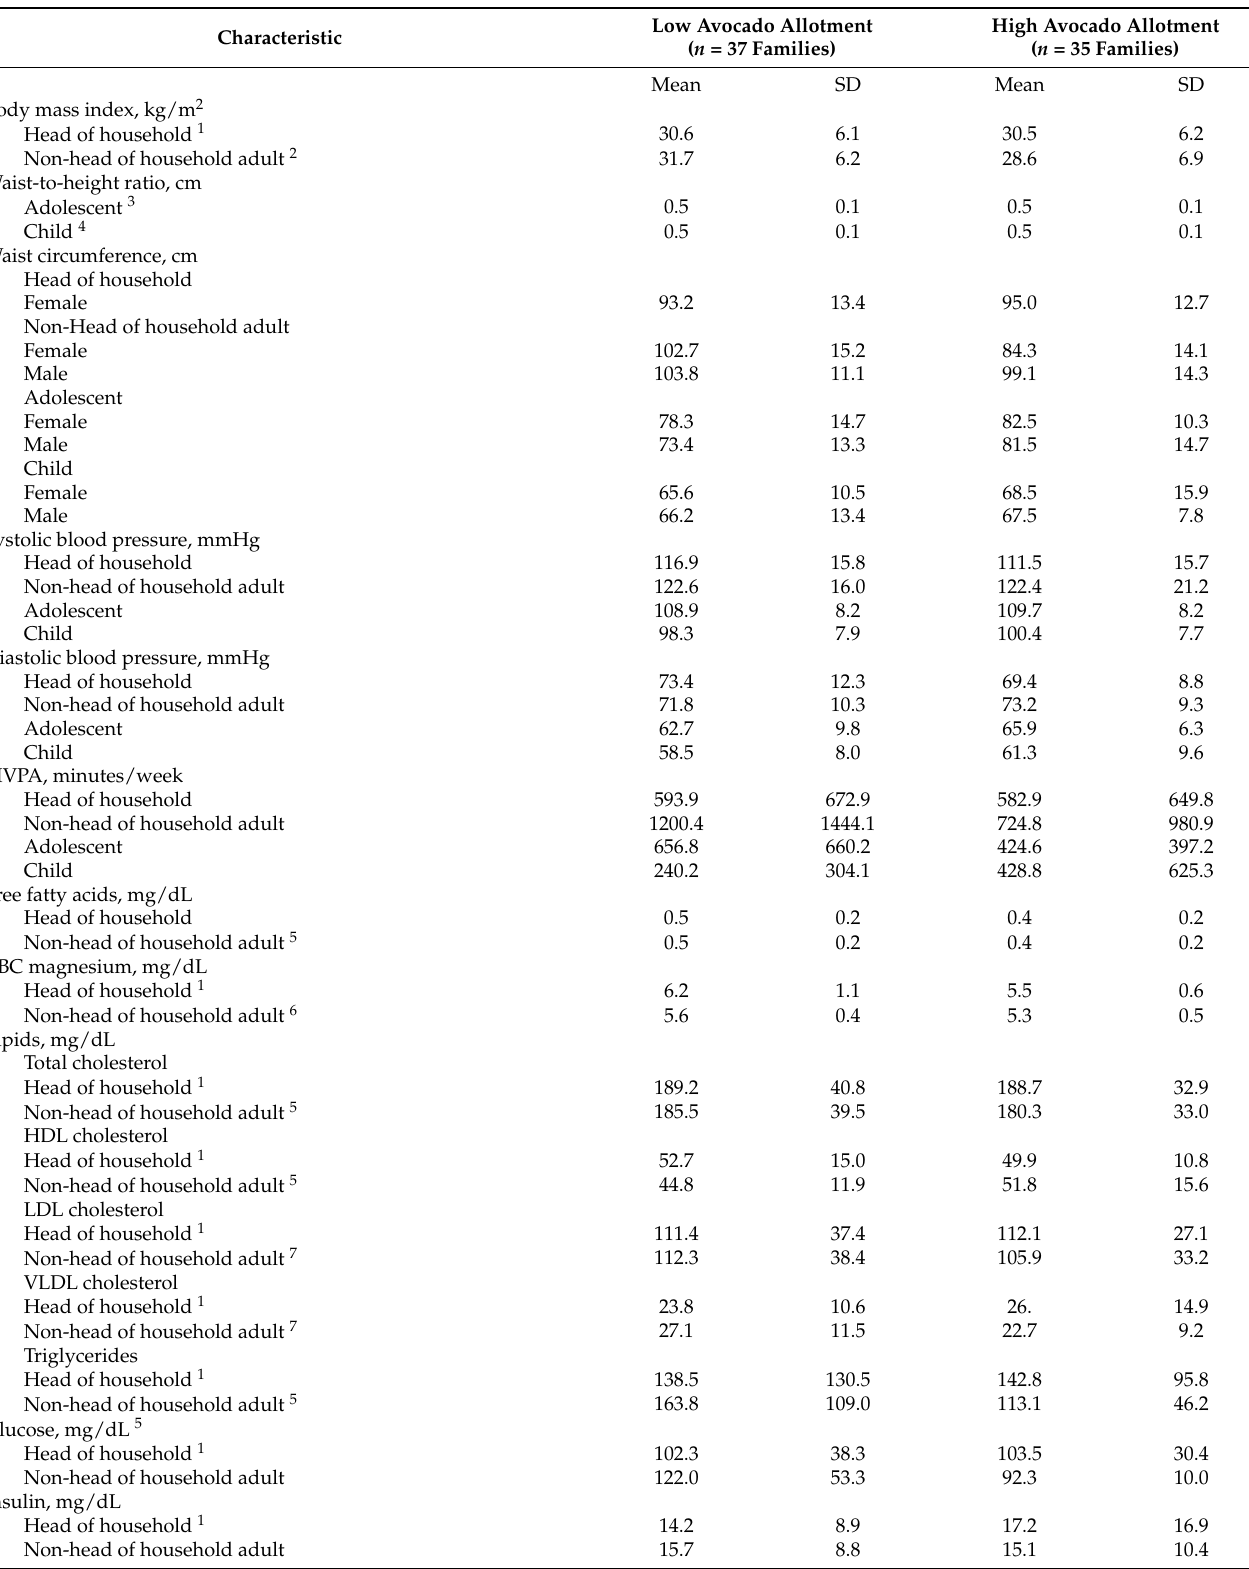
Table 2. Baseline anthropometric and clinical characteristics of randomized families participating in the Effects of Avocado Intake on the Nutritional Status of Families